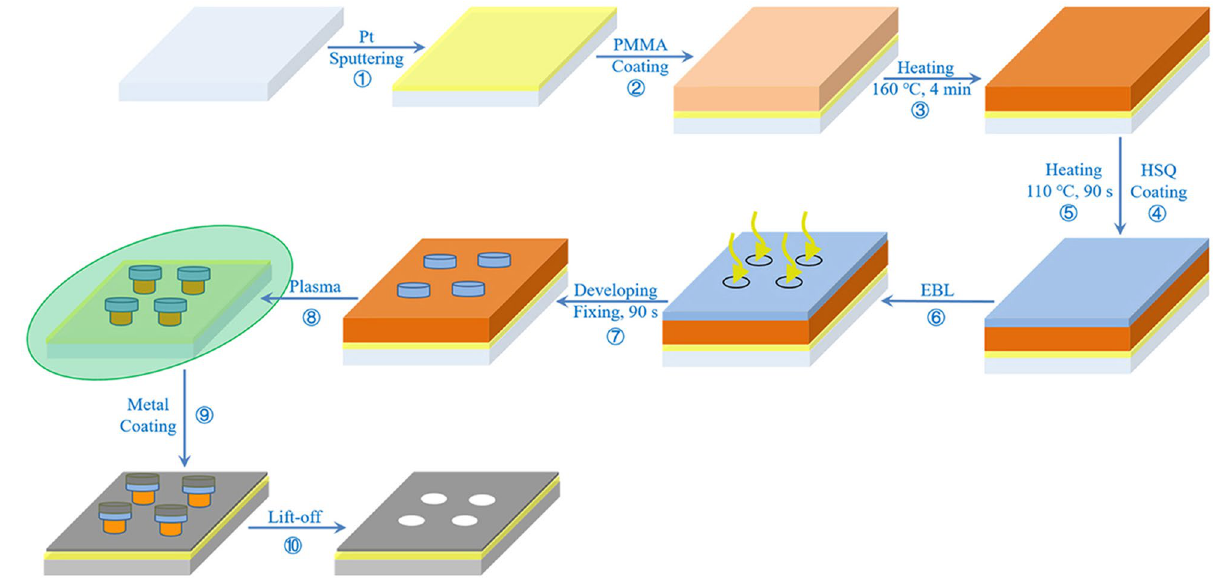
Figure 1. Synthesis process of metal nanopore array fabrication.